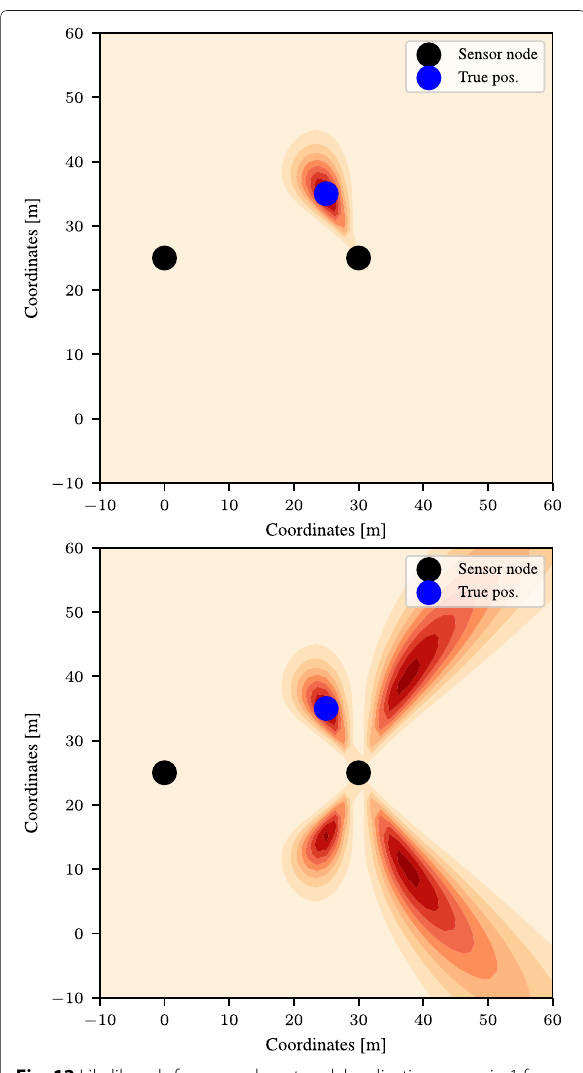
Fig. 13 Likelihoods for example network localization scenario 2 for the unambiguous DOA sensor and the BATS DOA sensor. True position of the tracked object is at [25,35]. a Unambiguous bearing. b Ambiguous